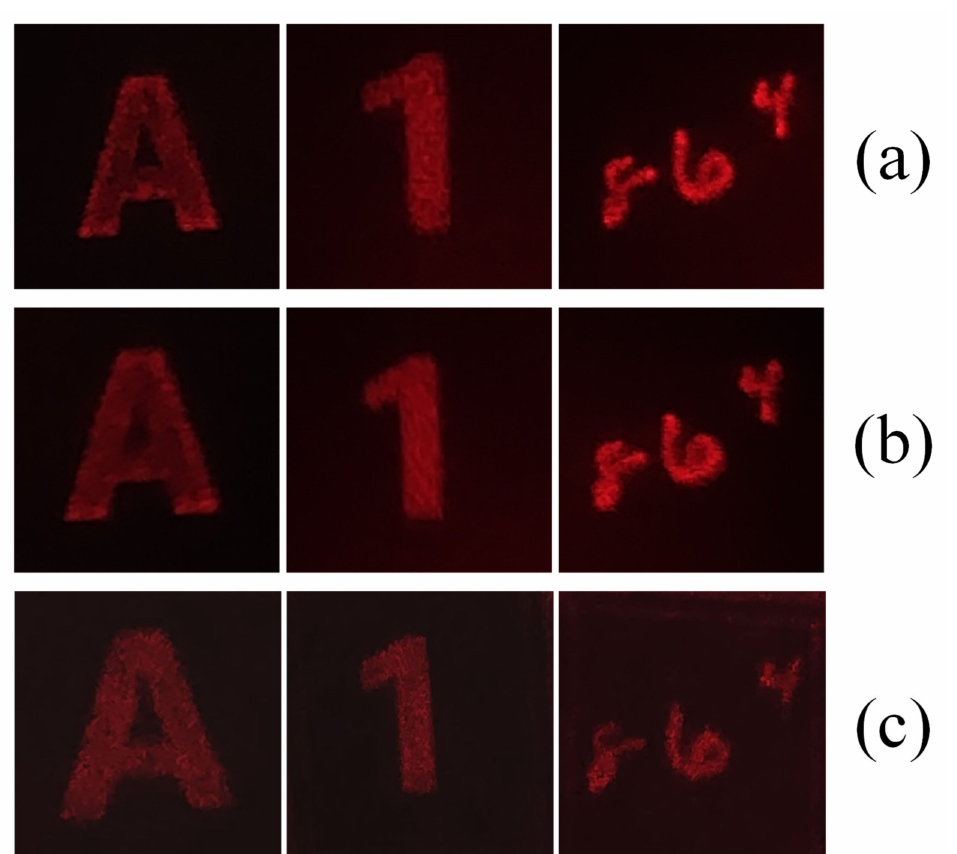
Figure 9. Optical reconstruction results of single-plane simple images. Three images in row ( a ) are the reconstructed images of the results obtained by the iterative ASM, row ( b ) is the reconstructed image of the results obtained by the network for the corresponding image, and row ( c ) is the reconstructed image of the results obtained by holo-encoder for the corresponding